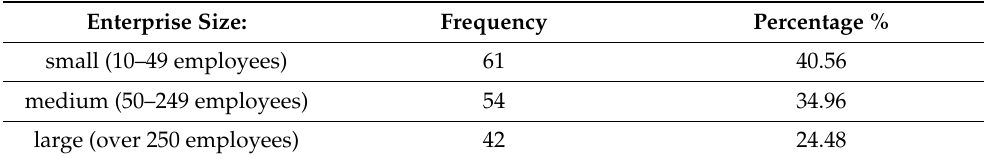
Table 2. Characteristics of the enterprises surveyed ( n = 157).